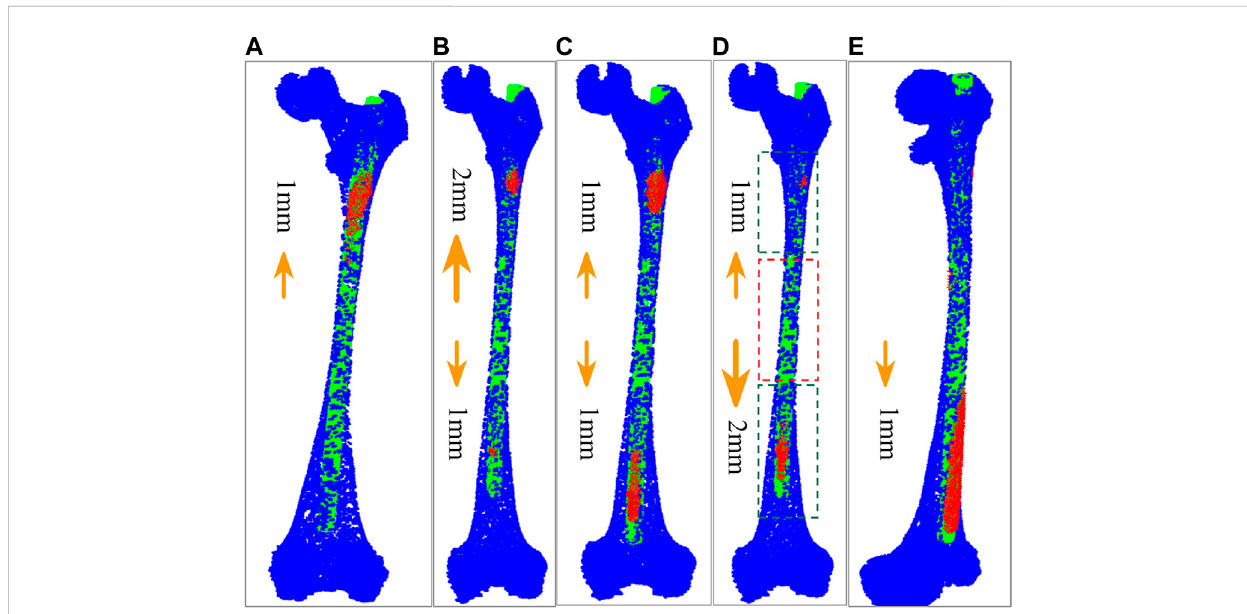
FIGURE 4 Fivegrowth schemesdeterminedaccordingtothedistributionofoutsidepoints. (A) ThecenterlineofMCisthmusincreases1 mmupwardatatime. (B) The isthmus centerline increases 2 mm upward and 1 mm downward at a time. (C) The isthmus centerline increases 1 mm upward and downward respectivelyeachtime. (D) Theisthmuscenterlineincreases1 mmupwardand2 mmdownwardeachtime.Thepartinreddashedcontouristheisthmus, while the parts in green dashed contours represent the growing volumes. (E) The isthmus centerline increases 1 mm downward each